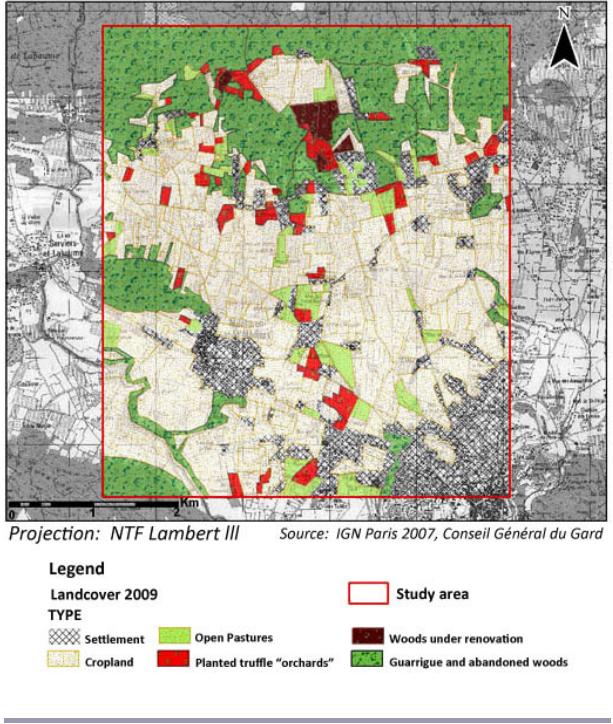
Fig. 6 . Distribution of holm-oak ( Quercus ilex L.) and black truffle ( Tuber melanosporum Vittad.) rural forest in cultivation and renovated guarrigue (scrubland-open forest) areas for production of truffle at the landscape level in Uzès,